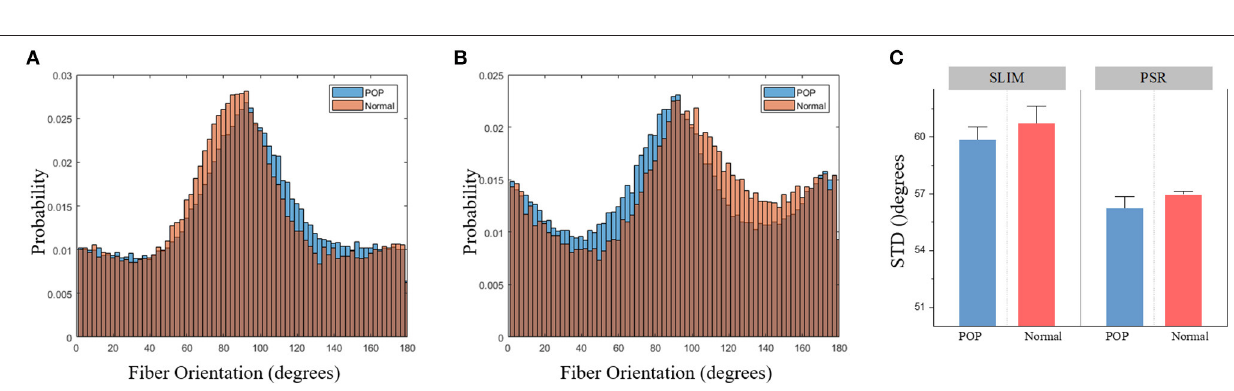
FIGURE 4 | (A) The histogram of fiber orientation segmentation from SLIM images. (B) The histogram of fiber orientation segmentation from PSR images. (C) Standard deviation of fiber orientation for each tissue